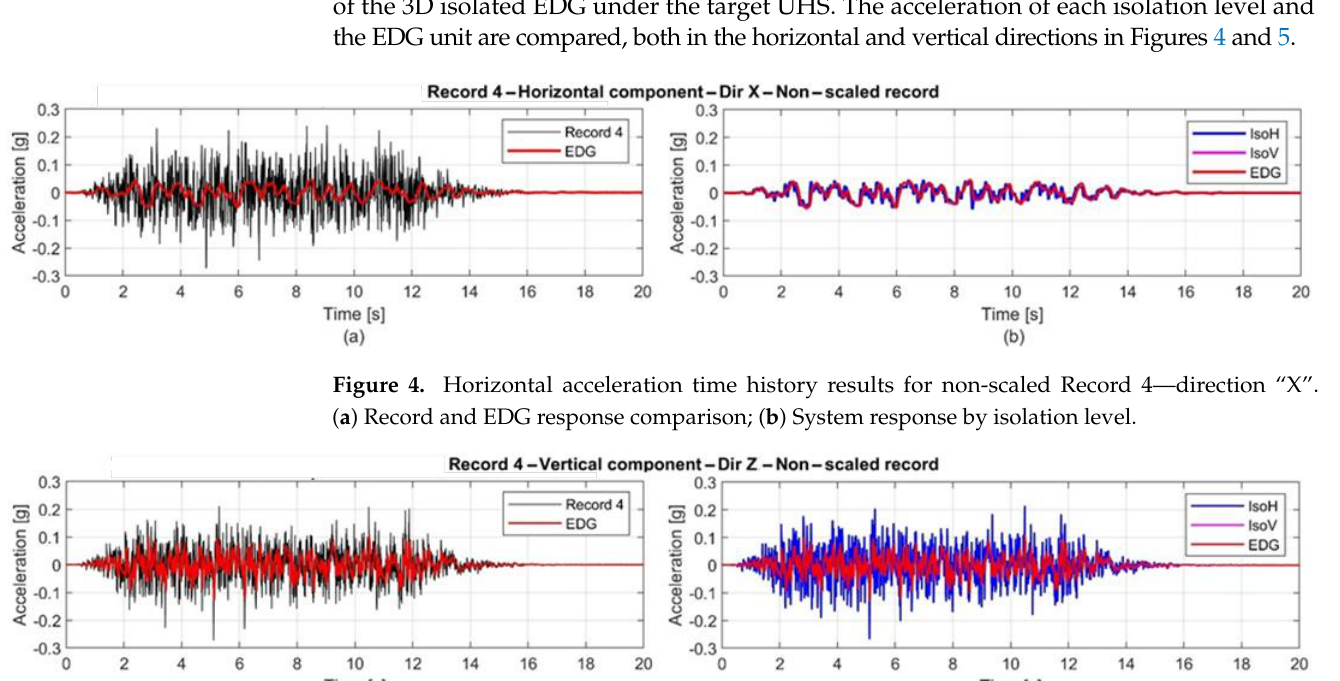
Figure 5. Vertical acceleration time history results for non-scaled Record 4—direction “Z”. ( a ) Rec- ord and EDG response comparison; ( b ) System response by isolation level.